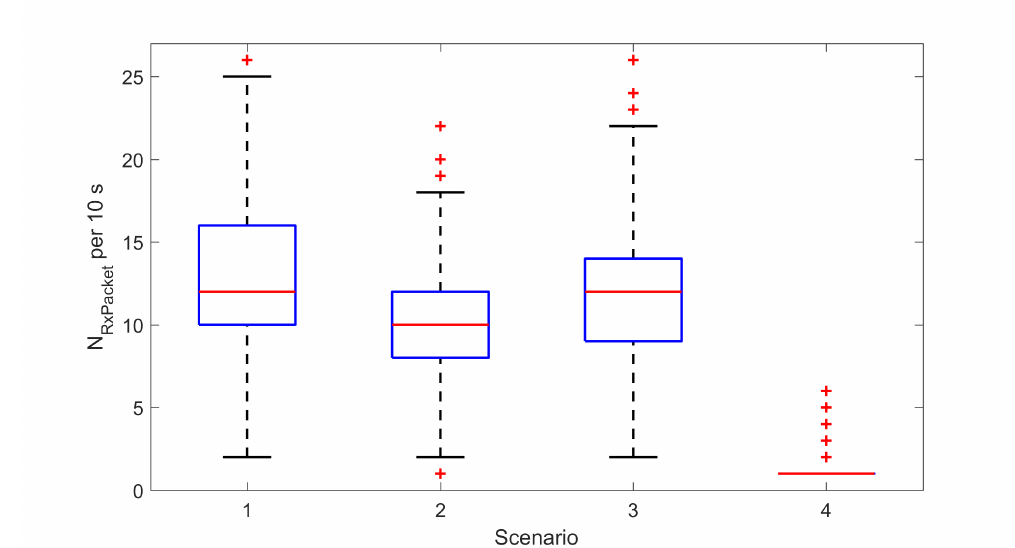
Figure 3. The number of ADV packets received ( N RxPacket ) by the S1 scanner from a single node in all data intervals, for different evaluation scenario. The number of packets received in scenario 4 drops significantly due to active scanning and intermittent operation of the node.